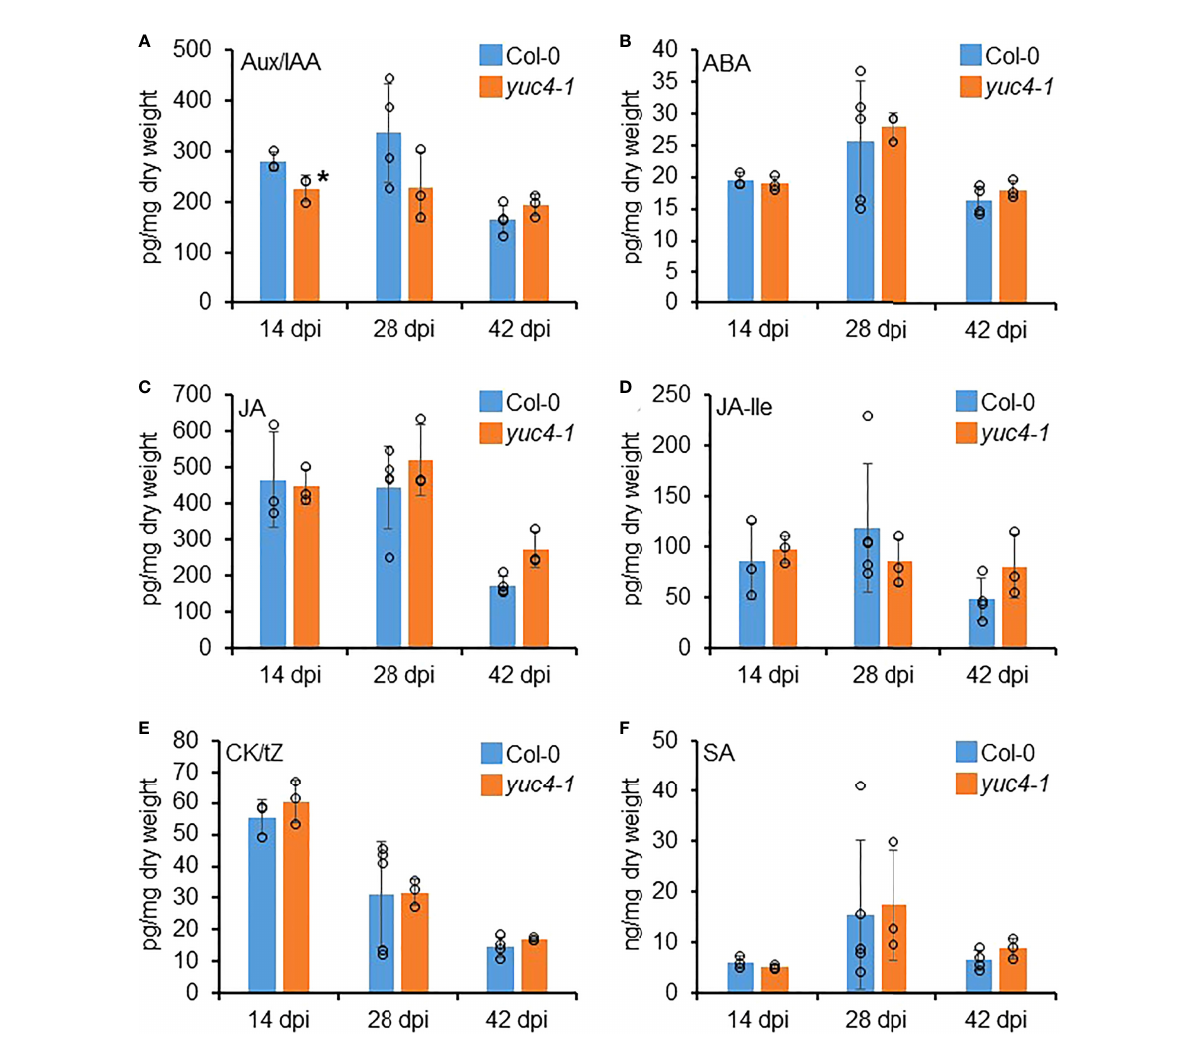
FIGURE 6 YUC4 affects hormone levels in galls. Hormone levels of (A) auxin/indole-3-acetic acid (Aux/IAA), (B) abscisic acid (ABA), (C) jasmonic acid (JA), (D) JA isoleucine (JA-Ile), (E) cytokinine/trans-zeatin (CK/tZ) and (F) salicyclic acid (SA) in Col-0 and yuc4-1 14, 28 and 42 DPI galls. Averages from n ≥ 3 ± SD are shown, circles denote individual data points, * denotes signi fi cant difference from Col-0, P<0.05, Student ’ s T-test. Three biological replicates were performed with similar results. Data from 0~14 DPI are shown in Supplemental Figure